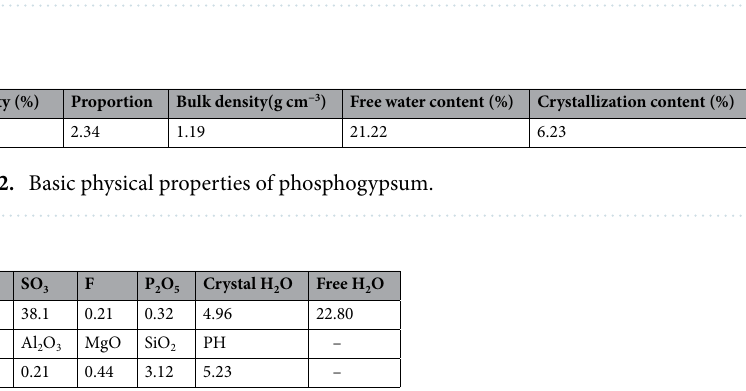
Table 1. Heavy metal content of phosphogypsum and MSWI fly ash.